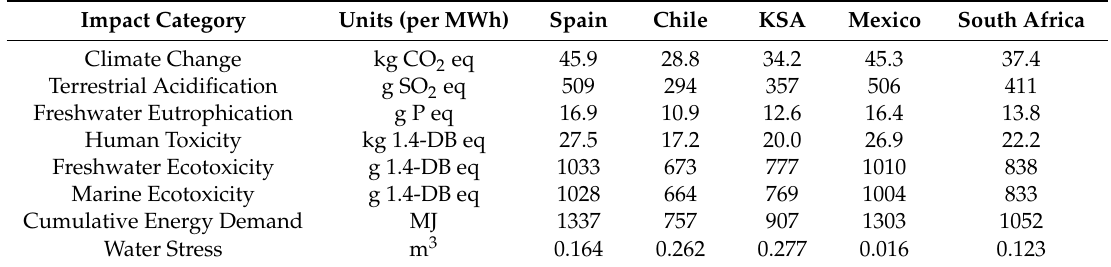
Table 3. Characterized impacts of the HYSOL configuration in five geographic locations.